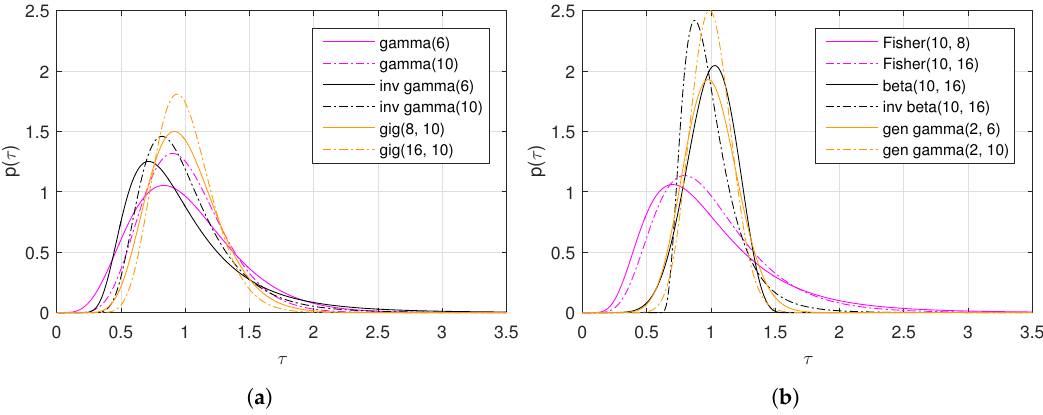
Figure 1. Examples of different texture distributions. ( a ) PDFs of the gamma ( gamma(6) and gamma(10) ), the inverse gamma ( inv gamma(6) and inv gamma(10) ) and the GIG ( gig(8, 10) and gig(16, 10) ) distributions. ( b ) PDFs of the Fisher ( Fisher(10, 8) and Fisher(10, 16) ), the beta ( beta(10, 16) ), the inverted beta ( inv beta(10, 16) ), and the generalized gamma ( gen gamma(2, 6) and gen gamma(2, 10) )